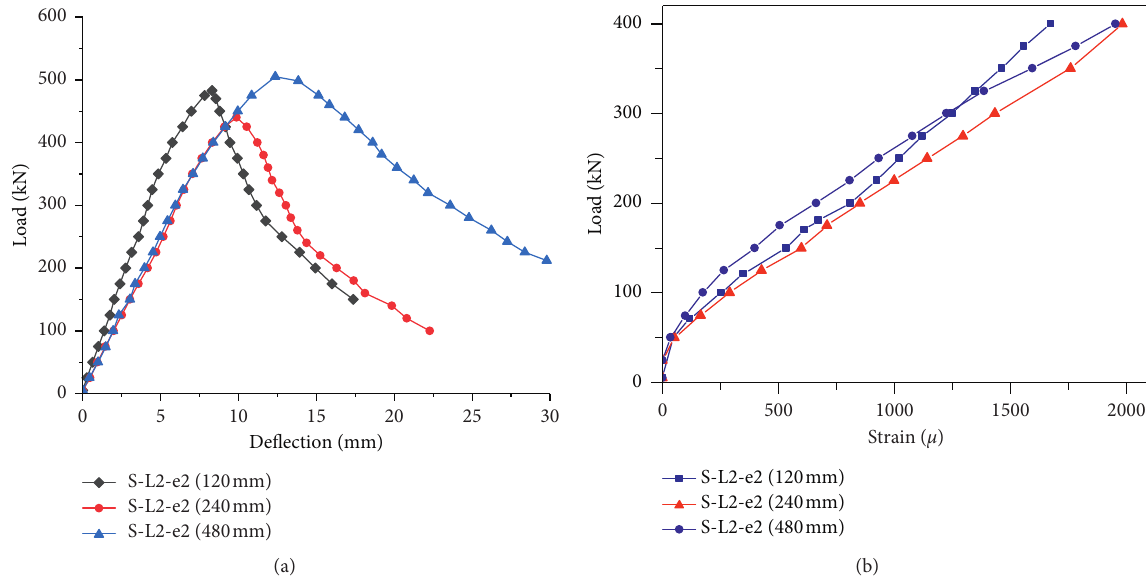
Figure 8: Load-strain responses of eccentrically loaded columns with different overlap lengths. (a) Load-lateral deflection curves of eccentrically loaded columns at different overlap lengths. (b) Load-maximum compressive strain curves of concrete at different overlap